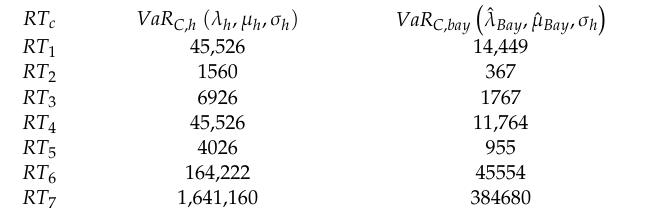
Table 12. The VaR under Historical and Bayesian LDA by risk category (in 1000 s of MAD ).